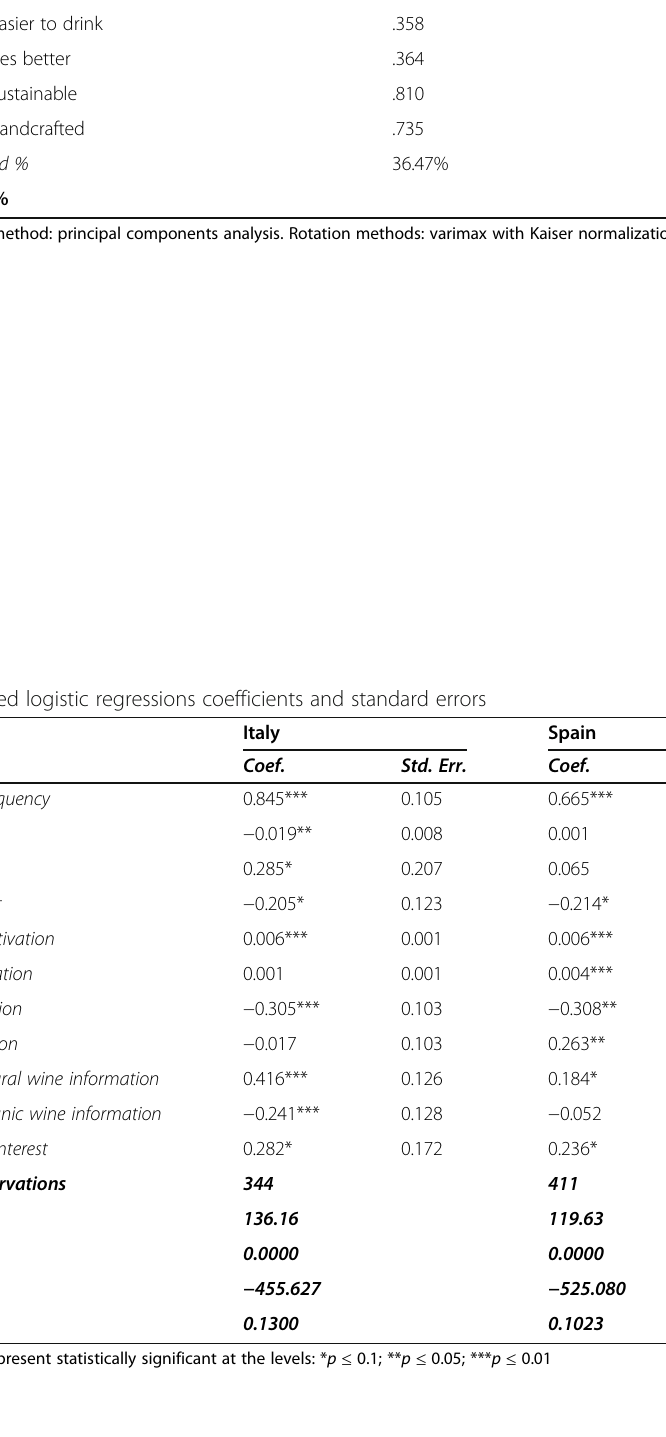
Table 7 Matrix of the rotated components Factor loadings Natural wine is healthier .791 .256 Natural wine makes me less drunk .335 .762 Natural wine causes less hangover .417 .726 Natural wine is trendy − .455 .559 Natural wine is easier to drink .358 .716 Natural wine tastes better .364 .428 Natural wine is sustainable .810 .179 .735 .221